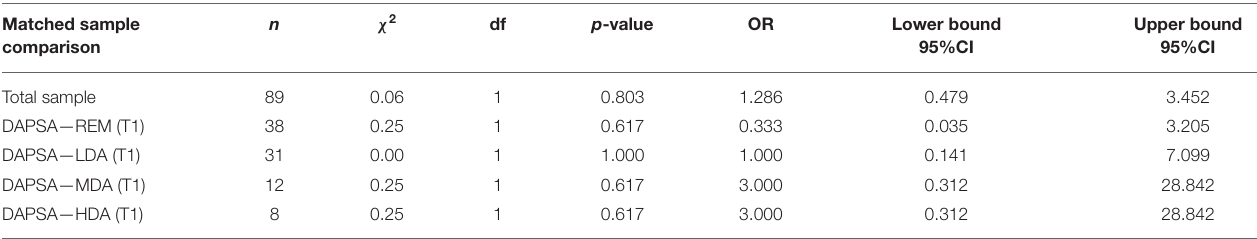
TABLE 3 | McNemar tests for dichotomized PHQ-2 scores for the total sample and stratified by initial DAPSA levels at the first assessment before and during the SARS-CoV-2 pandemic. Matched sample